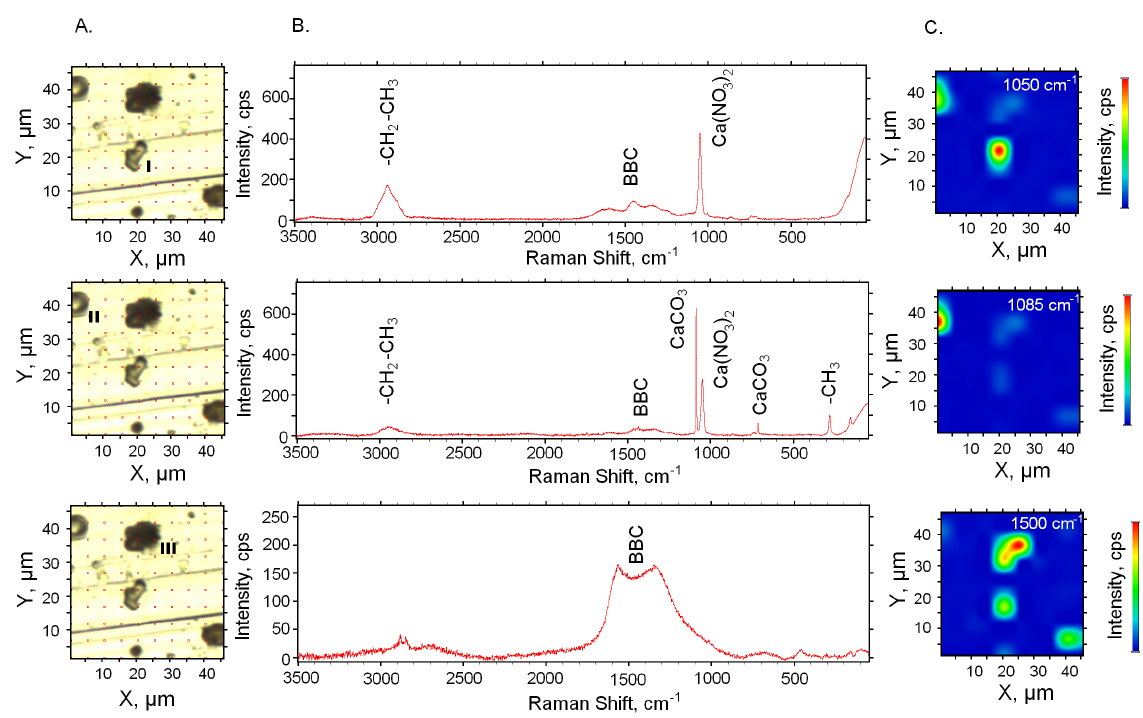
Fig. 7. In (A) , microscopic image of Particles I, II, and III collected from upwind location July 22 at ∼ 9:00p.m. In (B) , the full Raman spectra of Particle I, II, and III are shown. In (C) , spectral maps of major components of the particles are shown including Ca (NO 3 ) 2 at 1050cm − 1 , CaCO 3 at 1085cm − 1 , and black or brown carbon (BBC) at ∼ 1500cm − 1